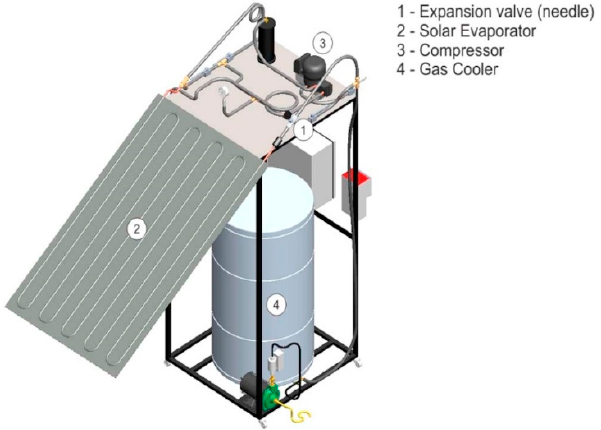
Figure 7. Schematic representation of the experimental device. Reproduced with permission from [122]. Elsevier, 2016.